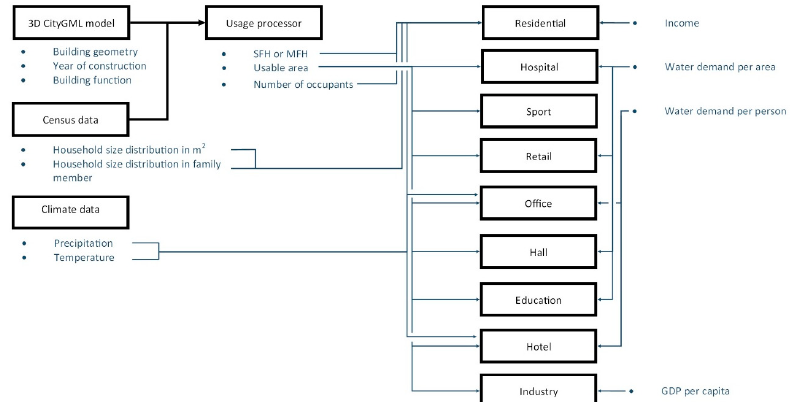
Figure 2. Information flow of inputs from CityGML, other sources and intermediate result to the water demand simulation of each building function. Information needed for calculations is marked in blue.